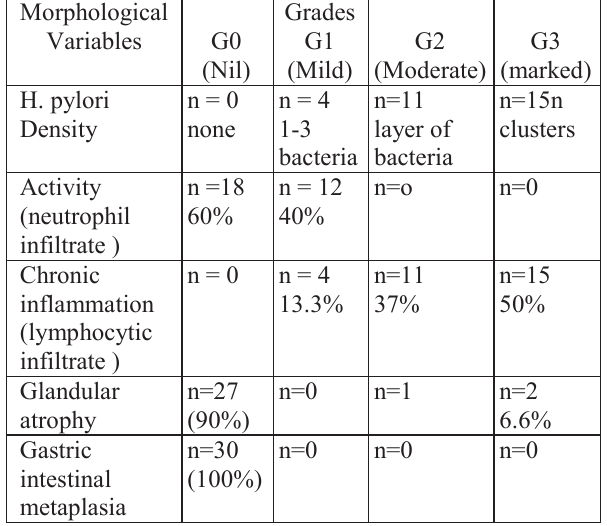
Table-2: Grading of histopathological variables of antral and corporal mucosa according to the Updated